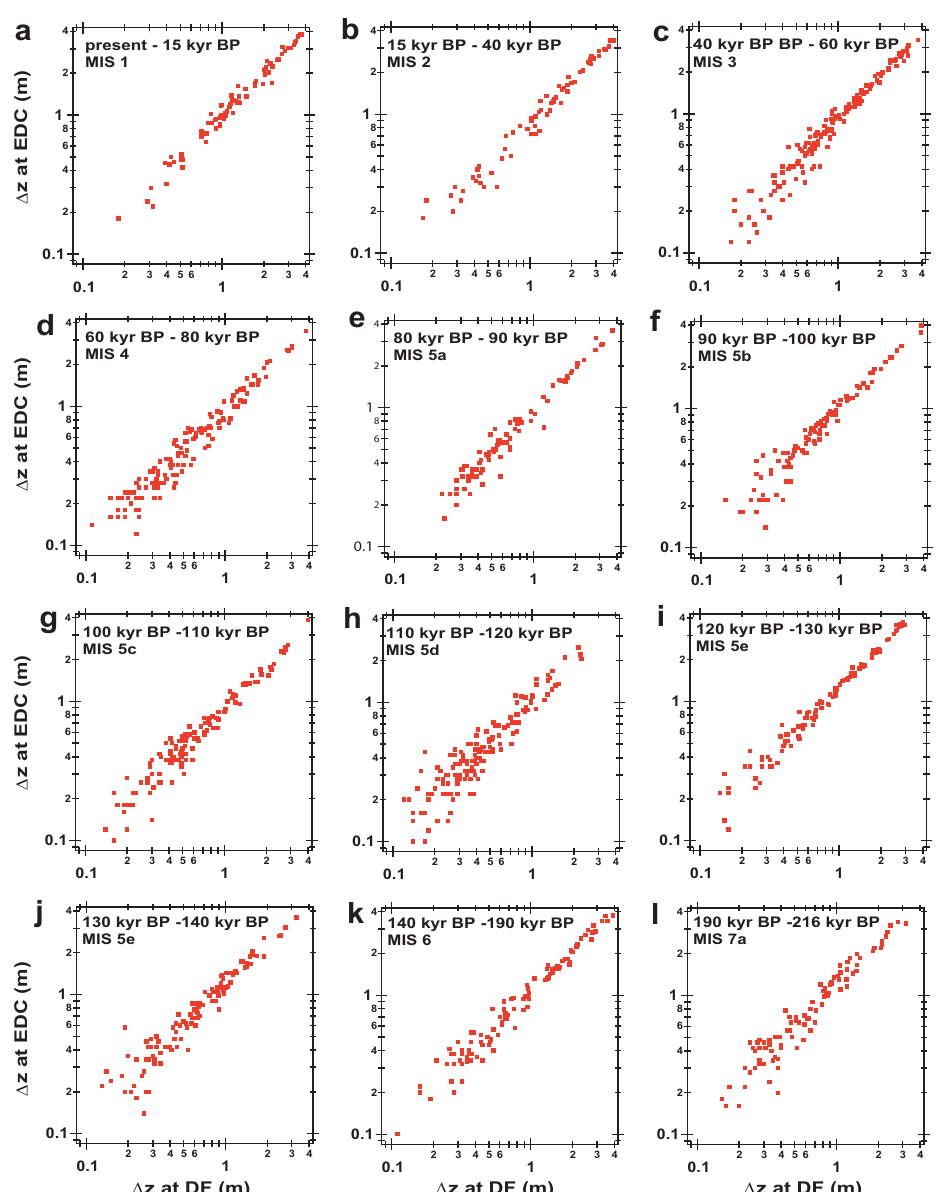
Figure B3. Along the sequence of the 1401 DF–EDC tie points, the depth spans between adjacent tie points were calculated for depths of both DF and EDC cores. Here, (cid:49)z i = z i + 1 − z i , where i is an integer from 1 to 1400. Then, X – Y plots were made as (cid:49)z i at DF versus (cid:49)z i at EDC. Figures from a to l are for age span on DFO2006 and at the marine isotope stages (MIS) indicated in each figure. With this figure, we can see to what extent depth span between adjacent tie points deviated between (cid:49)z i at DF and (cid:49)z i at EDC. We observe that they are in most cases within ∼